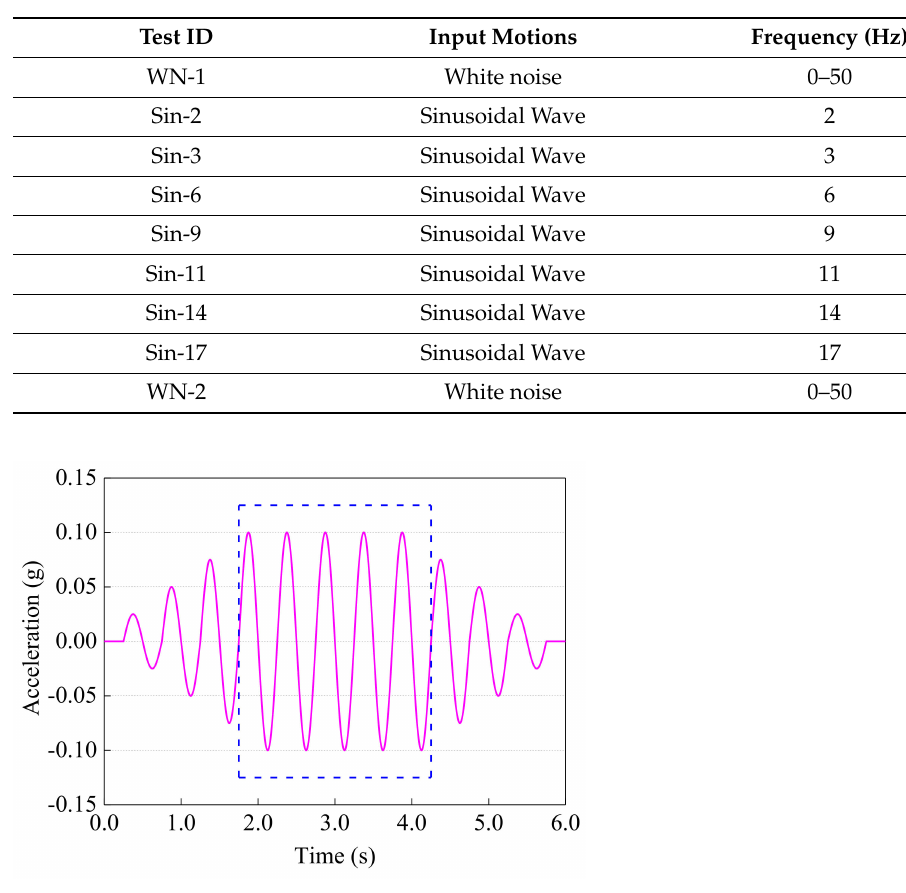
Table 5. Testing cases.